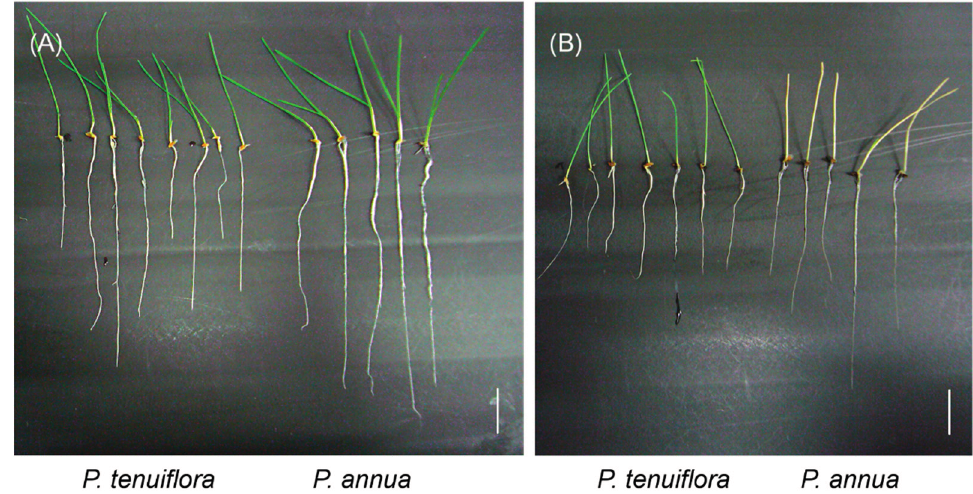
Figure 1. Stress tolerance of P. tenuiflora (left) and P. annua (right). Seedlings of P. annua and P. annua were hydroponically grown for nine days and were transferred to the nutrient solution containing 0 ( A ); or 300 mM NaHCO 3 ( B ), and were grown for another five days. White bars = 1